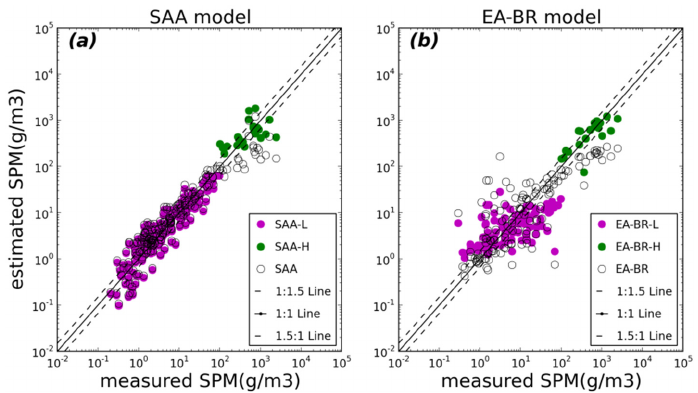
Figure 8. Comparison of the measured and inversed SPM values when ( a ) SAA ; and ( b ) EA-BR models are applied to the DS-V in situ data set. Open, green, and pink circles stand for the version of each model developed over the Whole, High and Low SPM ranges, respectively (see Table 3). Solid lines represent 1:1 line and dashed lines represent 1.5:1, 1:1.5 lines.